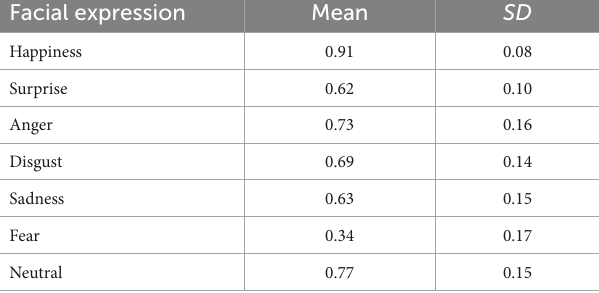
TABLE 2 Unbiased hit rates for emotional facial expressions in the emotion recognition task (means with standard deviations). Facial expression Mean